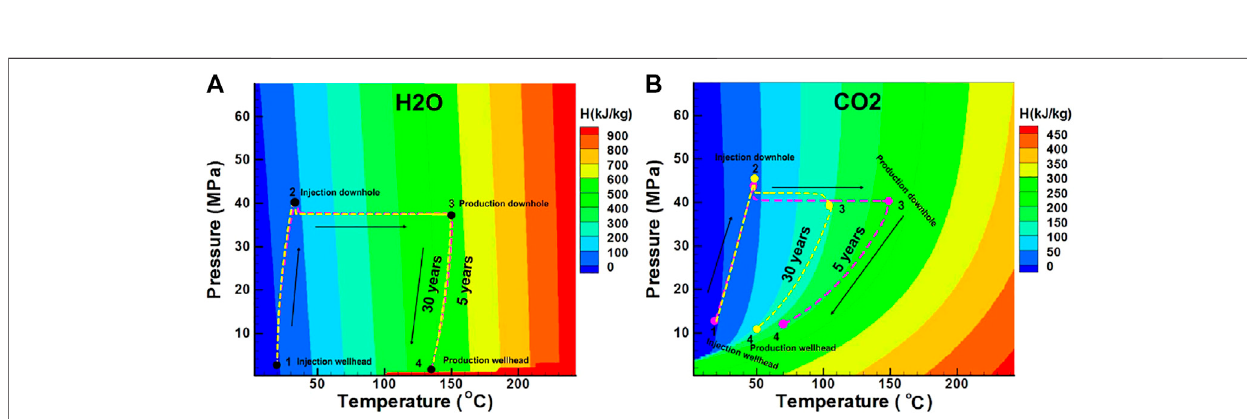
FIGURE 8 | Enthalpy changes along the fl ow path for (A) the CO 2 -based and (B) H 2 O-based EGS based on simulations. In both cases, the reference state (zero enthalpy) is chosen as ( T, P ) = (20 ° C, 10 MPa). Arrow upward denotes an increase, otherwise it denotes a decrease.